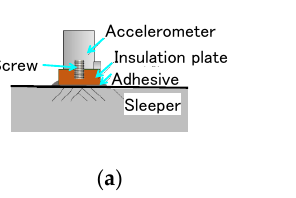
Figure 4. Sensor installation methods: ( a ) upper surface of the ladder sleeper; ( b ) in the ballast.